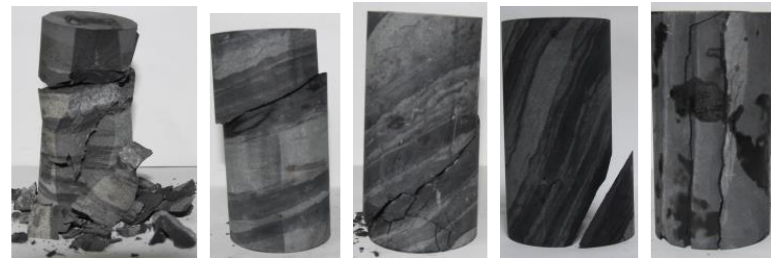
Figure 9. Typical failure picture of rock sample under saturated state.